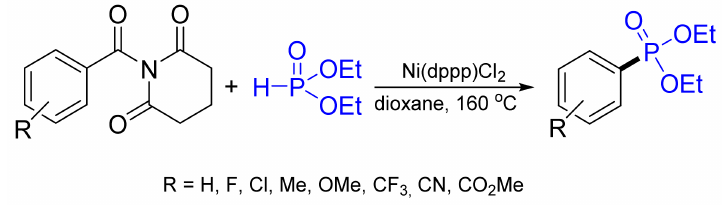
Figure 36. Phosphorylation of amides using Ni catalyst.